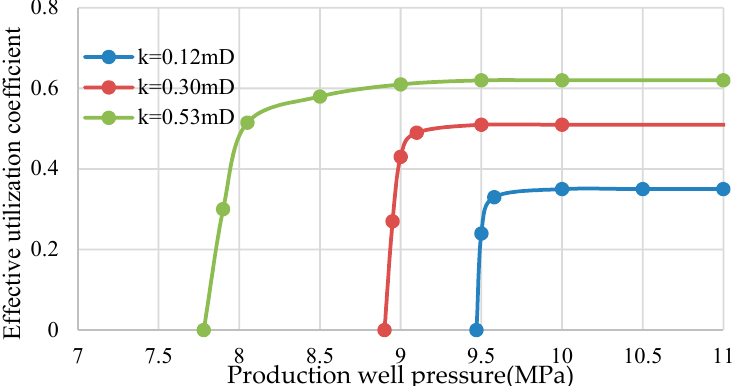
Figure 15. The relationship between the production rate and the production well pressure after fracturing.